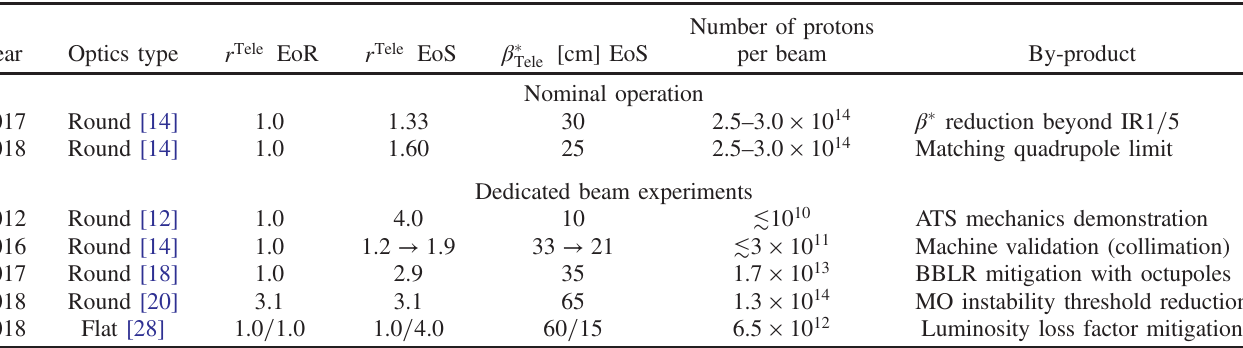
TABLE I. Summary of the various ATS optics configurations demonstrated so far in operation and in dedicated machine experiments: most relevant optics parameters at the end of ramp (EoR) and end of squeeze (EoS), typical beam intensity used, and main